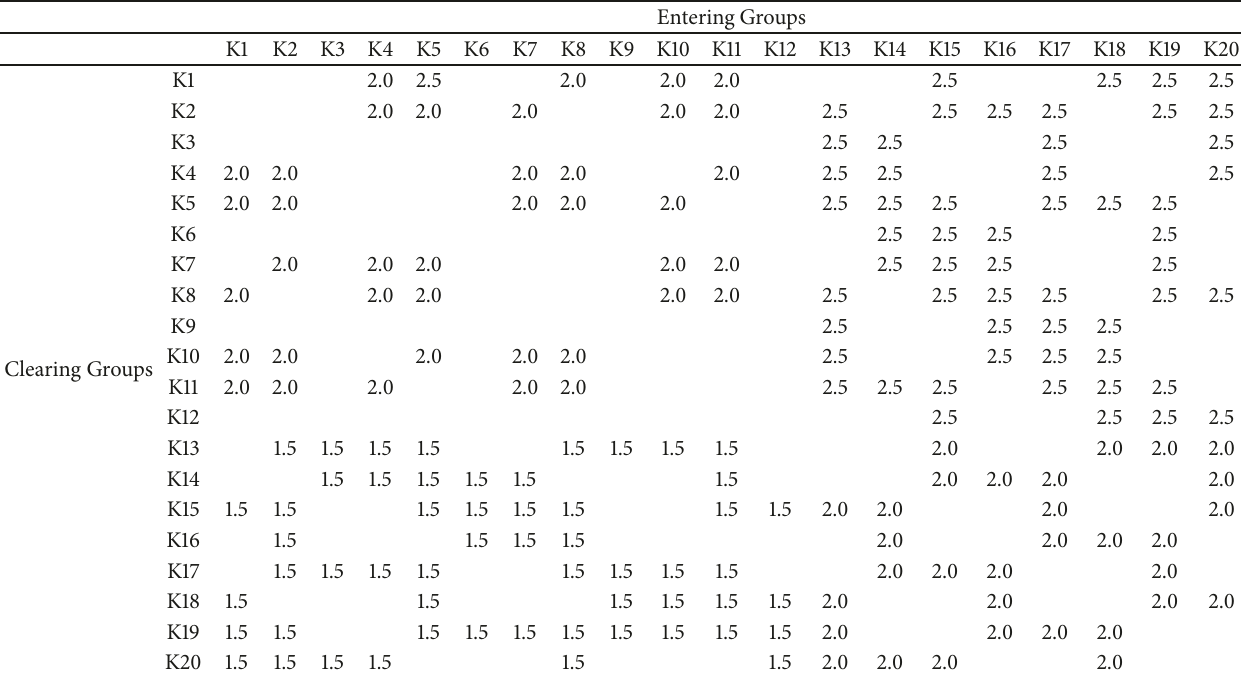
Table 3: List of 𝑡 𝑒𝑗 − 𝑆 𝑐𝑖 / V 𝑐𝑖